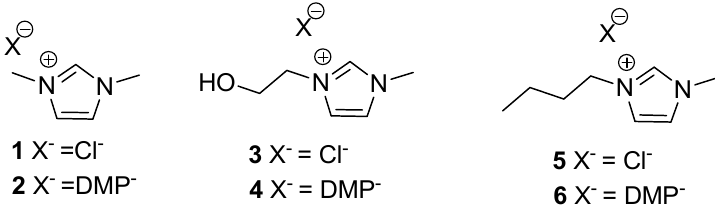
Figure 1. Tested 1‐alkyl‐3‐methyl imidazolium (MIM)‐based ionic liquids (ILs). Figure 1. Tested 1-alkyl-3-methyl imidazolium (MIM)-based ionic liquids